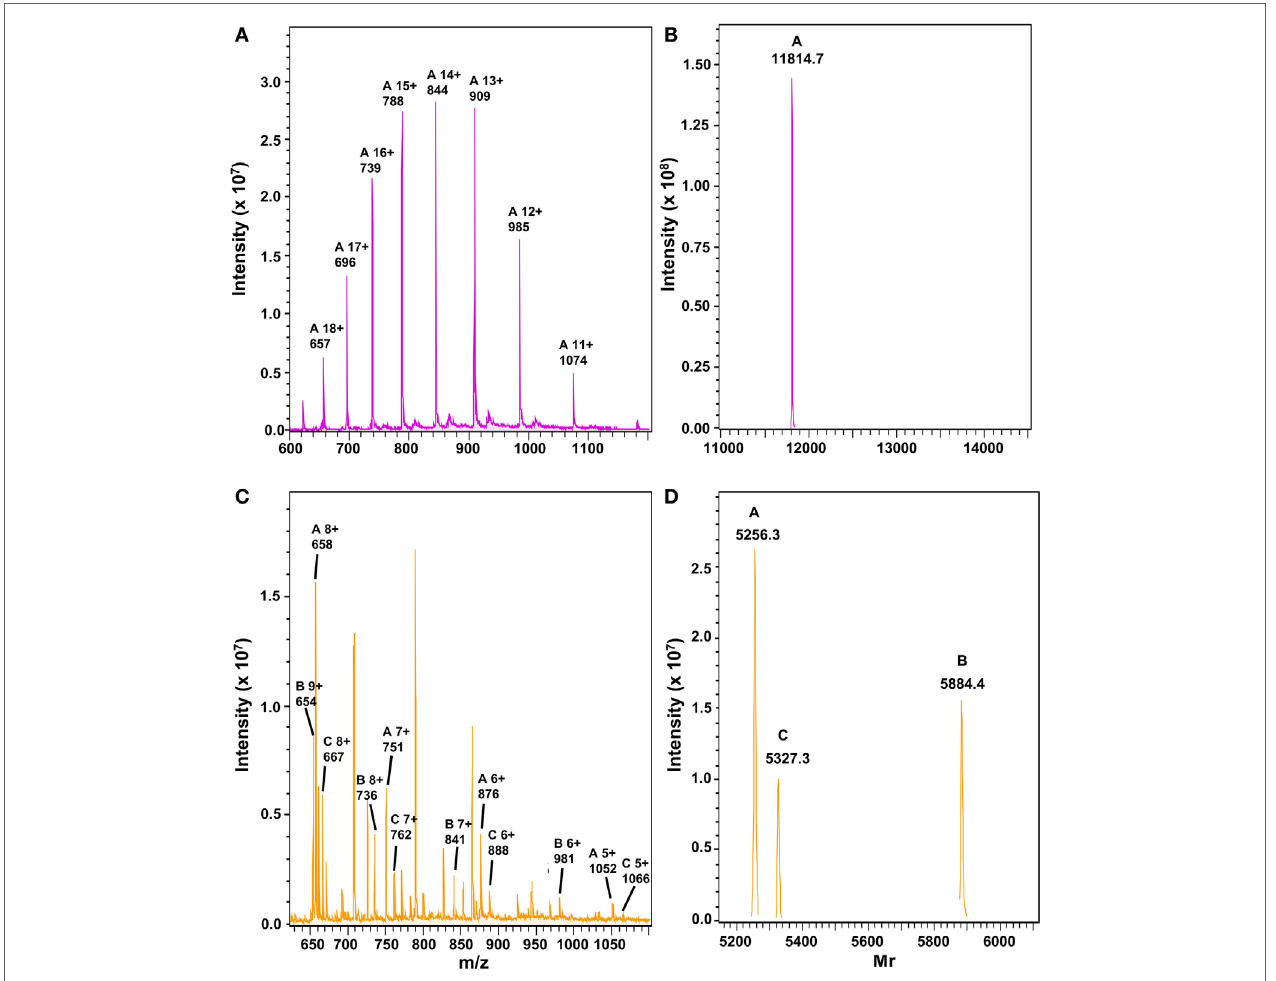
FigUre 2 | Mass spectrometric analysis of serum amyloid A1 (SAA1) after cleavage with matrix metalloproteinase-9 (MMP-9). Recombinant SAA1 was analyzed by electrospray ion trap mass spectrometry before (a,B) and after (c,D) incubation for 3 h at 37°C with active MMP-9. The unprocessed (a,c) and charge- deconvoluted (B,D) spectra are shown. The theoretical average relative molecular masses ( M r ) of intact SAA1, SAA1(52–104), SAA1(57–104), and SAA1(58–104) are 11,814.9, 5,884.4, 5,327.7, and 5,256.7, respectively.